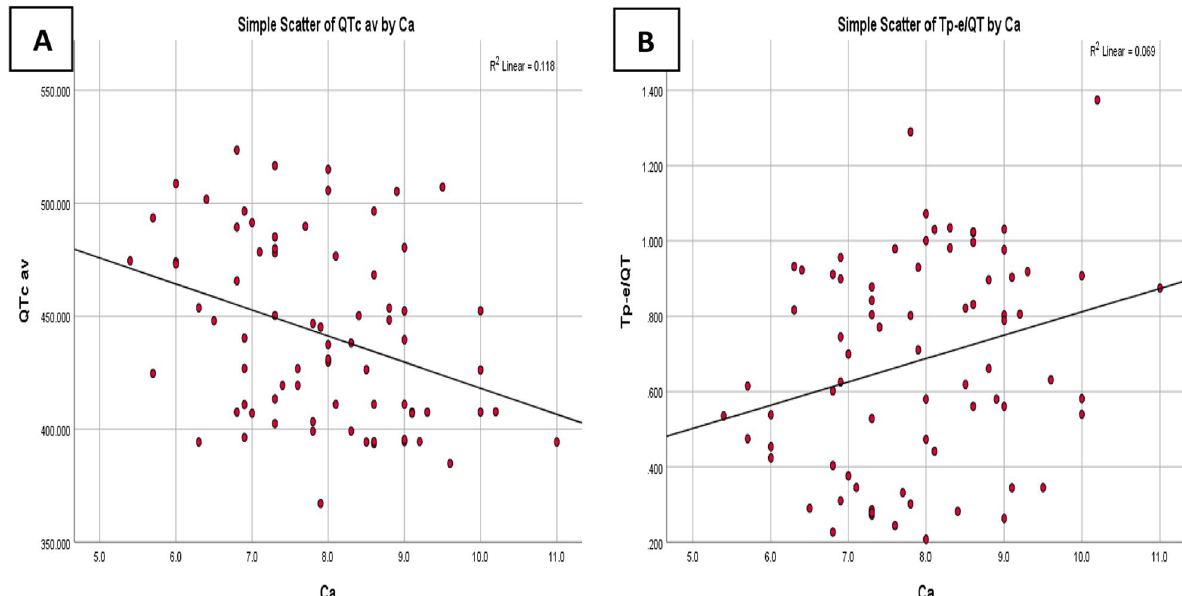
Fig. 1 A : Correlation between Calcium level and QTc average in CKD patients, B : Correlation between Calcium level and Tp-e/QT in CKD